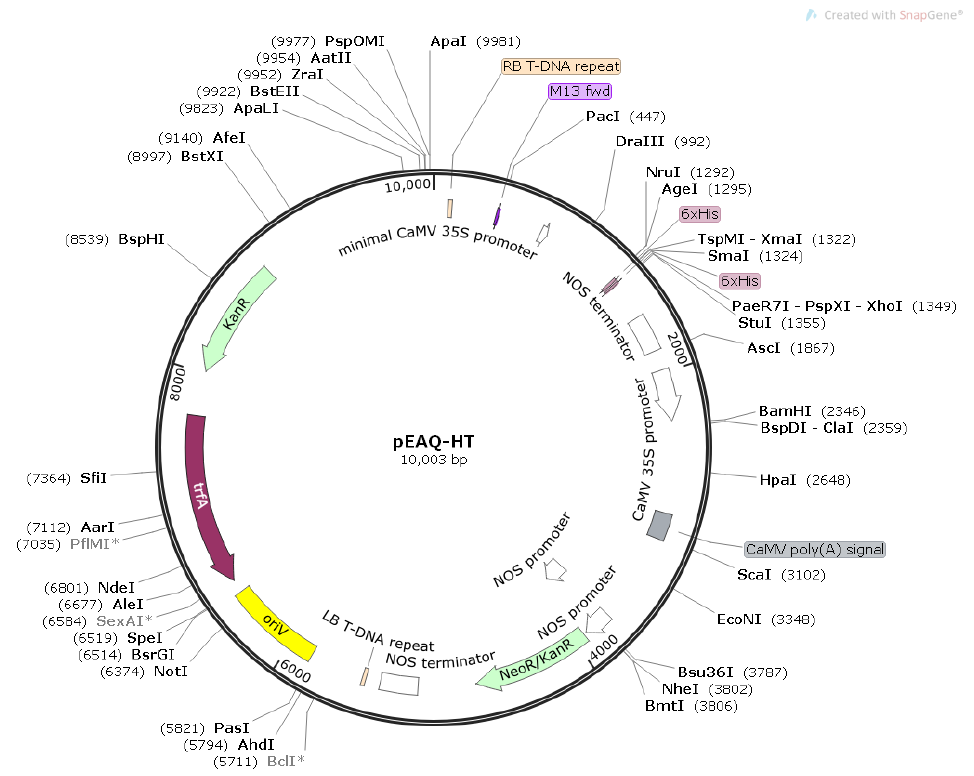
Figure A8. Map of the vector used for function validation of Xs GAO1 and Xs GAO2 in tobacco created with SnapGene. BclI* is methylation sensitive restriction endonuclease. Different protein showed with distinguished color.